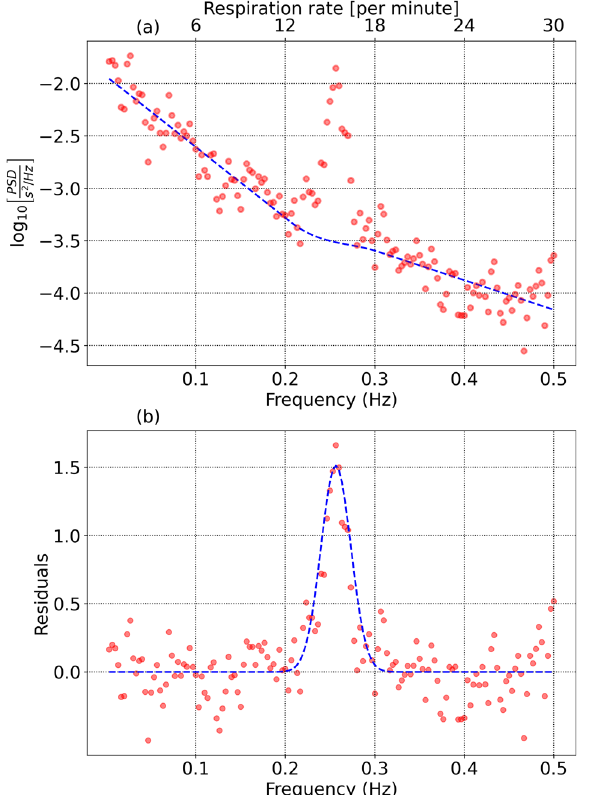
Fig. 7 Isolating the RSA component from the PSD. a HRV power spectral density consisting of background and Respiratory Sinus Arrhythmia. b Residuals after the background are subtracted.